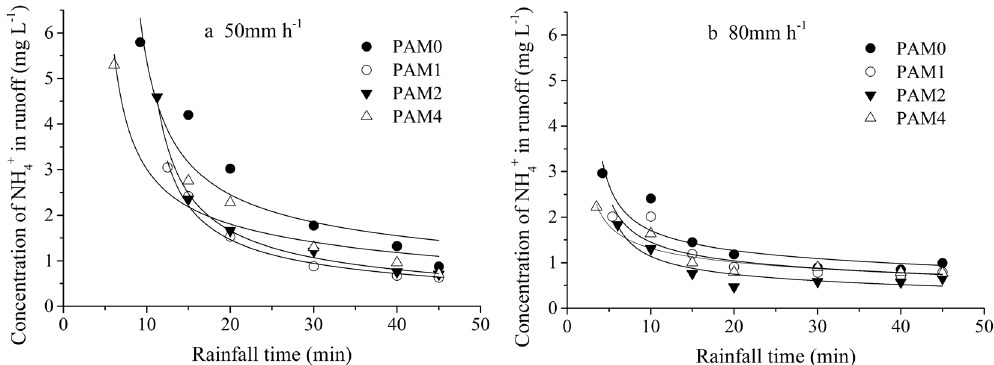
Figure 4. Concentration of NH 4 + in runoff versus rainfall time for different PAM application rates under ( a ) 50 mm·h − 1 rainfall intensity and ( b ) 80 mm·h − 1 rainfall